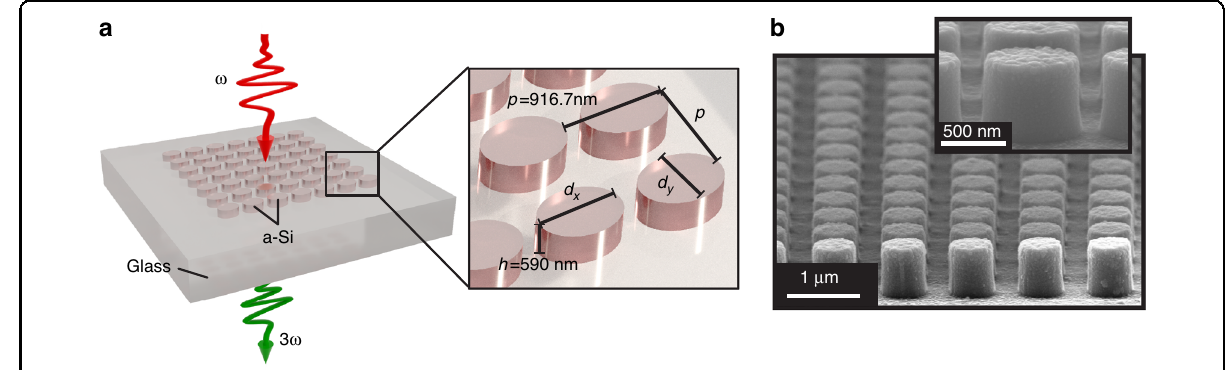
Fig. 1 Investigated setup. a Schematic of the fabricated all-dielectric metasurface for enhanced THG along with design parameters. b SEM image of the fabricated Si antennas. A single antenna is seen in the inset (sample is carbon-coated to mitigate charging